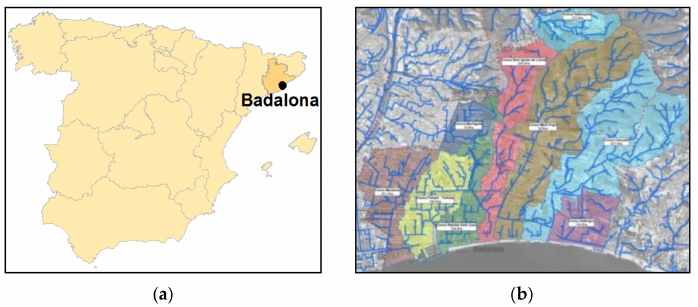
Figure 1. ( a ) Location of the city of Badalona; ( b ) Main water courses and catchments.